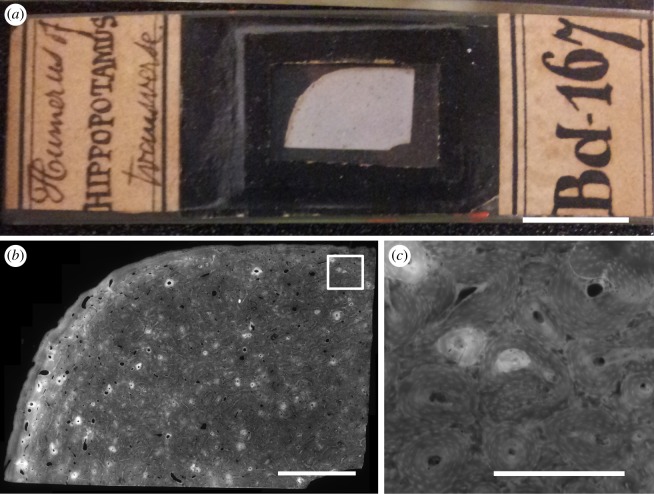
(a) Digital photograph of slide Bd 167 from the Quekett collection (scale bar 10 mm). (b) Fluorescence microscopic image of the same specimen, automatically stitched from 76 manually captured tile images (scale bar 2.5 mm). (c) Inset of (b) showing multiple secondary osteons (scale bar 0.5 mm). Images © The Royal College of Surgeons of England, reproduced here with their kind permission.